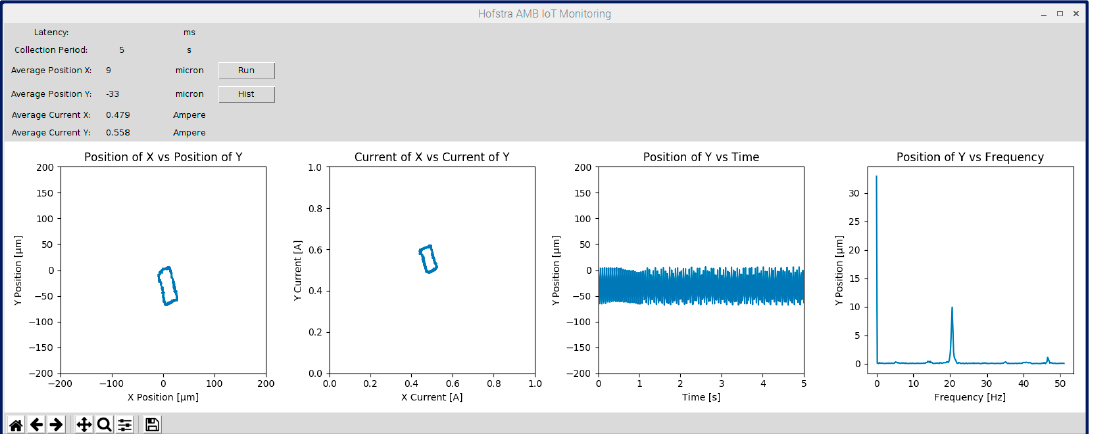
Figure 10. AMB IoT condition monitoring GUI display for rotating shaft with two collars and static unbalance.